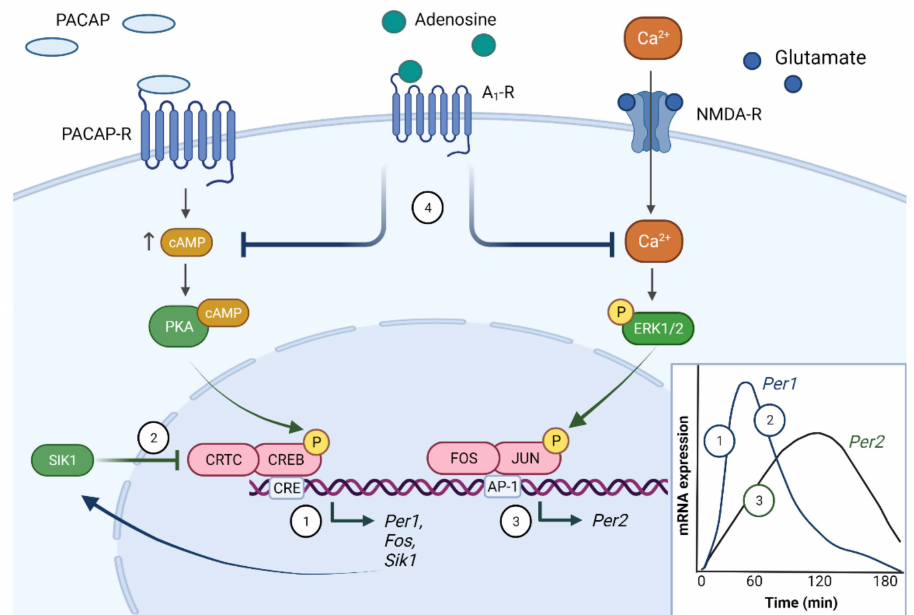
Figure 3. Molecular photoentrainment of the SCN. The light-induced release of glutamate and pituitary adenylate cyclase-activating polypeptide (PACAP) from the RHT nerve terminals leads to a rise in intracellular Ca 2+ and cAMP levels in the SCN. These trigger a cascade of events including activation of protein kinase A (PKA), which activates the transcription factor cAMP response element- binding protein (CREB), together with co-activators such as CREB-regulated transcription coactivator 1 (CRTC1). This leads to the upregulation of CRE-driven genes, including the core clock component, Per1 (1). In addition, Sik1 is upregulated, which feedbacks on the CREB pathway by phosphorylation of CRTC1. This deactivates CRTC1 leading to a decline in CREB-induced gene transcription and therefore a decline in Per1 expression (2). In parallel, the activation of ERK1/2 by Ca 2+ influx leads to the upregulation of the immediate-early transcription factors JUN and FOS. These heterodimerise to form AP-1, which drives Per2 transcription leading to an increase in Per2 expression (3). Adenosine, which accumulates in the extracellular space during wakefulness, modulates these light-activated signalling pathways. Adenosine predominantly signals through the G i (inhibitory) coupled A 1 receptor in the SCN, which results in a decrease in intracellular cAMP and Ca 2+ levels, and therefore a downregulation of the subsequent signalling events (4). Figure created with